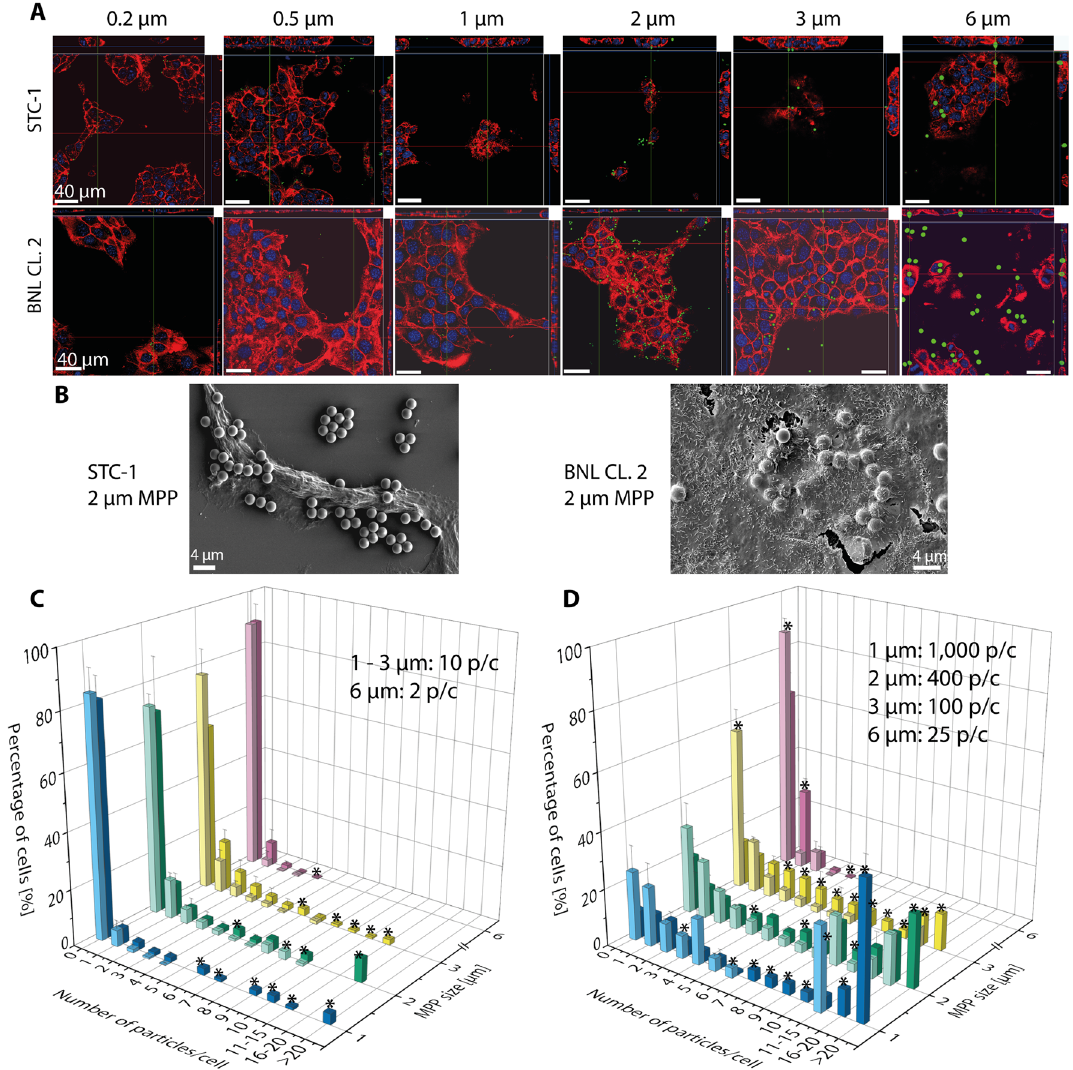
Figure 2. Analysis of the particle uptake by the epithelial cells (STC-1, BNL CL.2) as a function of size and concentration. Analysis was performed using confocal laser scanning microscopy (CLSM, A ), scanning electron microscopy (SEM, B ), and flow cytometry ( C , D ). ( A ) Size and number of added particles per cell: 0.2 µm: 750,000, 0.5 µm: 48,000, 1 µm: 2000, 2 µm: 700, 3 µm: 200, 6 µm: 25. Actin filaments were stained with rhodamine-phalloidin (red), nuclei were stained with DAPI (blue); FITC-fluorescent MPP are shown in green. Scale bars: 40 µm. ( B ) Representative SEM images are shown for each cell line in the presence of 2 µm MPP. Additional images are shown in Supplementary Fig. S2. Scale bars: 4 µm. ( C , D ) Results of flow cytometry measurements of STC-1 (light color) and BNL CL.2 (dark color) at low ( C ) and high ( D ) particle concentrations. The added number of particles per cell are given in the graph as p/c. No data are available for 0.2 and 0.5 µm particles due to lacking resolution of the flow cytometer. Data represent mean ± SD, n = 3. Stars represent statistically significant data points (p < 0.05) between both cell lines. For better clarity, no differentiation of significance level is